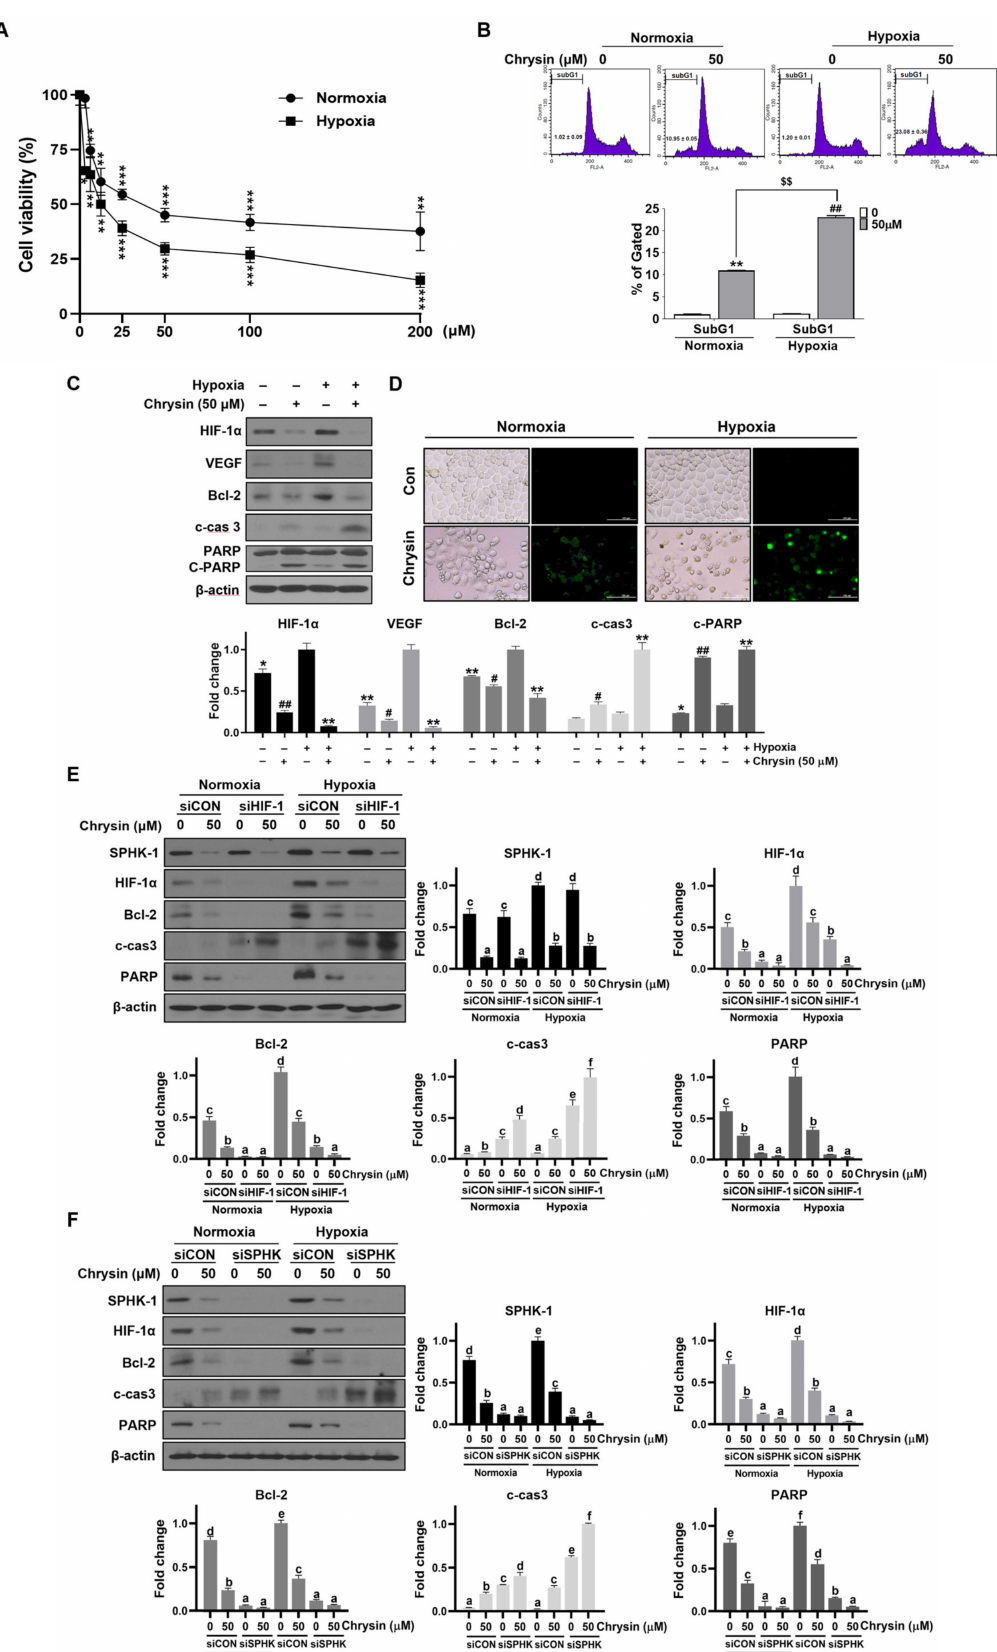
Figure 4. Effects of chrysin on apoptosis and the correlation between SPHK-1 and chrysin-induced apoptosis under hypoxia. ( A ) Effect of chrysin on the cytotoxicity of PC-3 cells for 24 h under